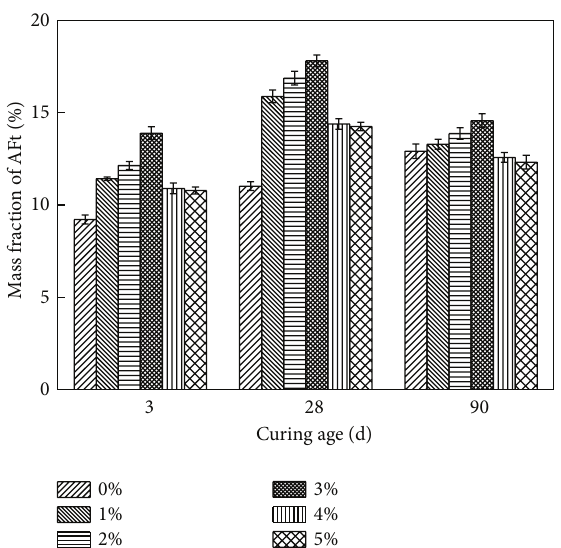
Figure 5: Contents of AFt in mortars with different dosages of NT at different ages.